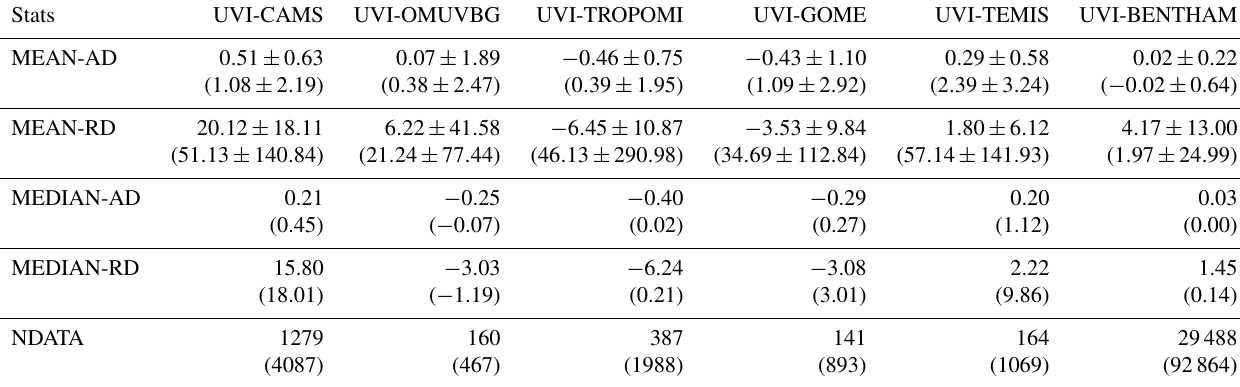
Table 4. Mean and median absolute and relative differences between CS-UVI (clear-sky UVI) satellite/model measurements and CS-UVI- RADIO at Saint-Denis. Mean and median absolute and relative differences between ALL-SKY-UVI satellite/model measurements and ALL- SKY-UVI-RADIO at Saint-Denis are in parentheses. NDATA signifies number of data points. Stats UVI-CAMS UVI-OMUVBG UVI-TROPOMI UVI-GOME UVI-TEMIS UVI-BENTHAM